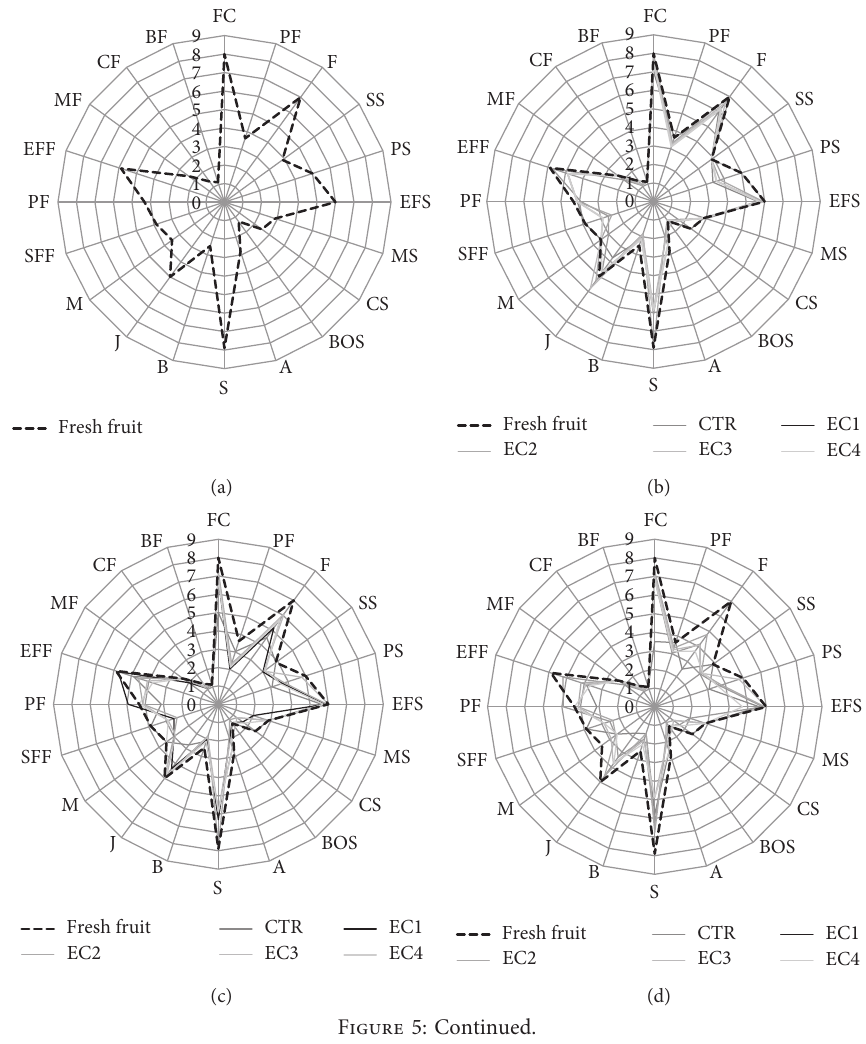
Figure 4: O 2 (kPa) and CO 2 (kPa) trend of papaya fresh-cut fruits during storage at 5 equal letters in each